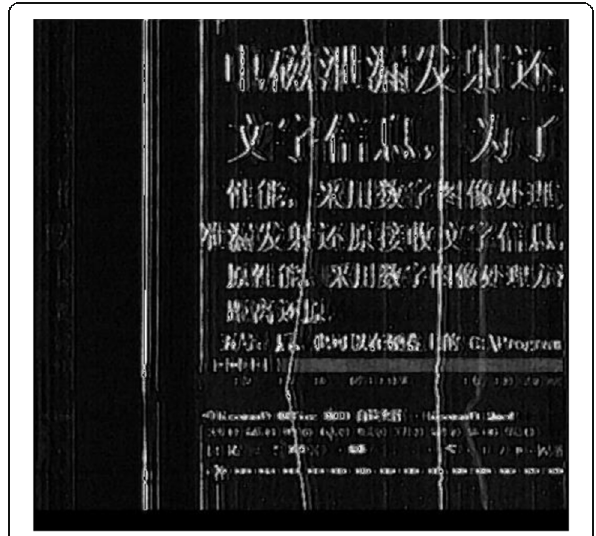
Fig. 8 Weighted mean filtering → fuzzy sharpening → fuzzy enhancement